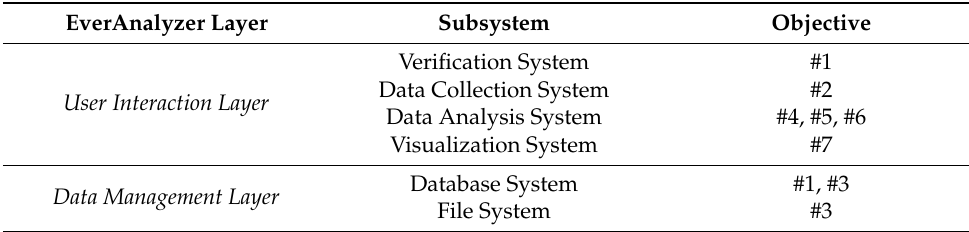
Table 2. Correspondence of subsystems and EverAnalyzer objectives.